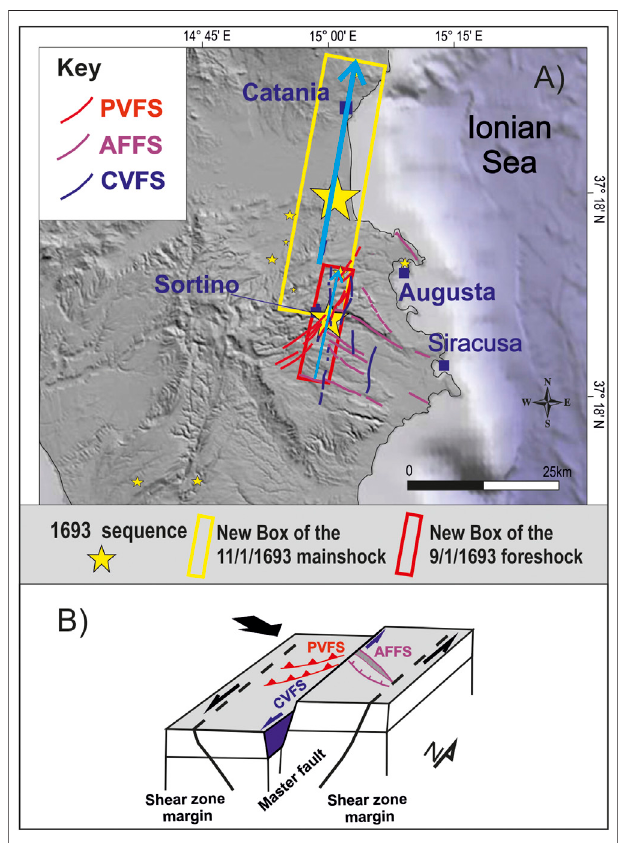
FIGURE 13 | (A) South-eastern Sicily DEM; red and yellow rectangles are the new modeled seismic sources; arrows indicate the hypothesized rupture directivity and verse of propagation of the rupture. (B) Model of a transtensivefaultwithitsassociatedextensionalandcontractionalfaults; black arrow indicates sigma